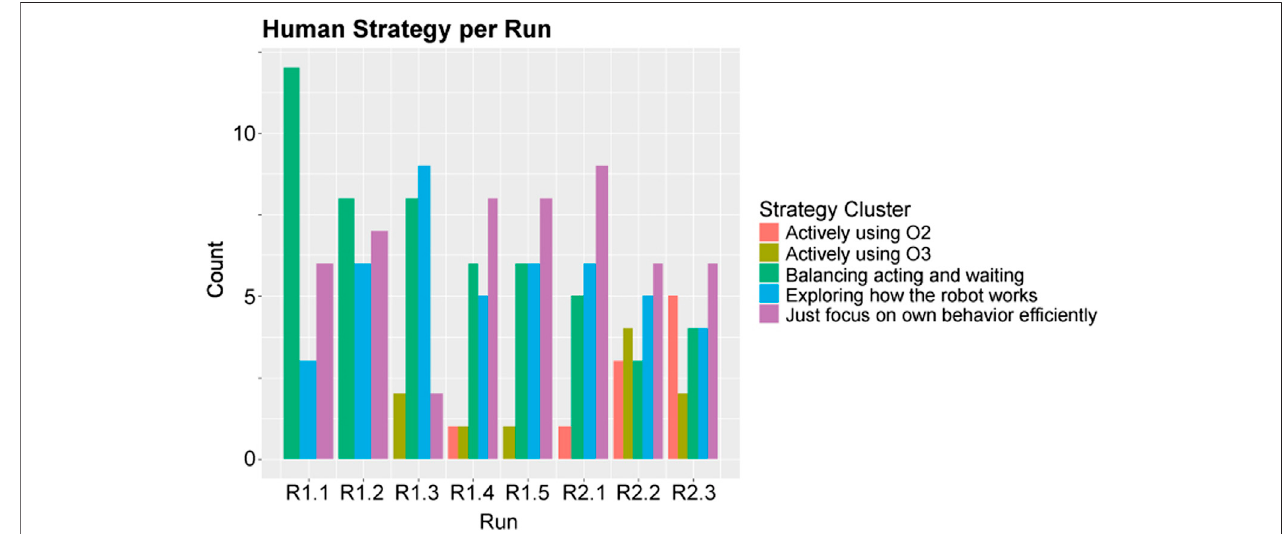
FIGURE 9 | An overview of how many participants used speci fi c behavioral strategies per run.